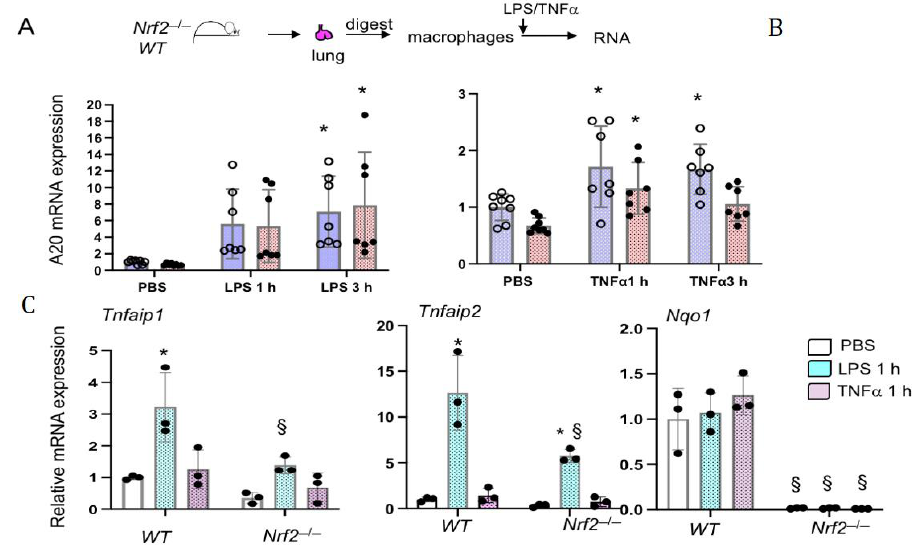
Figure 3. Nrf2 does not regulate LPS-stimulated A20 transcriptional induction in LDM Φ s ex vivo. Lungs from wildtype (WT) and Nrf2 − / − mice (males and females, 2-3 mice) were harvested and digested separately for macrophage isolation as outlined in schema (see methods for details). Lung- derived macrophages (LDM Φ s) were treated with 100 ng/mL LPS ( A ) or 10 ng/ml TNF α ( B ) for 1 h or 3 h. Values of PBS controls used are the same as those used in panel A, as TNF α was used along with LPS treatment. LPS and TNF α stimulated A20 expression levels in BMDM Φ s of male and female mice are shown in Figure S2. ( C ) Tnfaip1 , Tnfaip2 and Nqo1 mRNA expression in LDM Φ s isolated from male mice treated with LPS and TNF α ex vivo for 1 h is shown. * versus PBS; § versus WT counterparts.